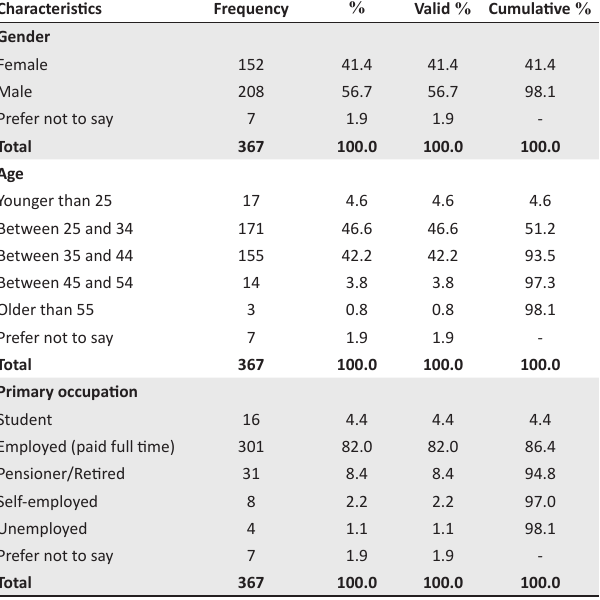
TABLE 2: Demographic characteristics of the